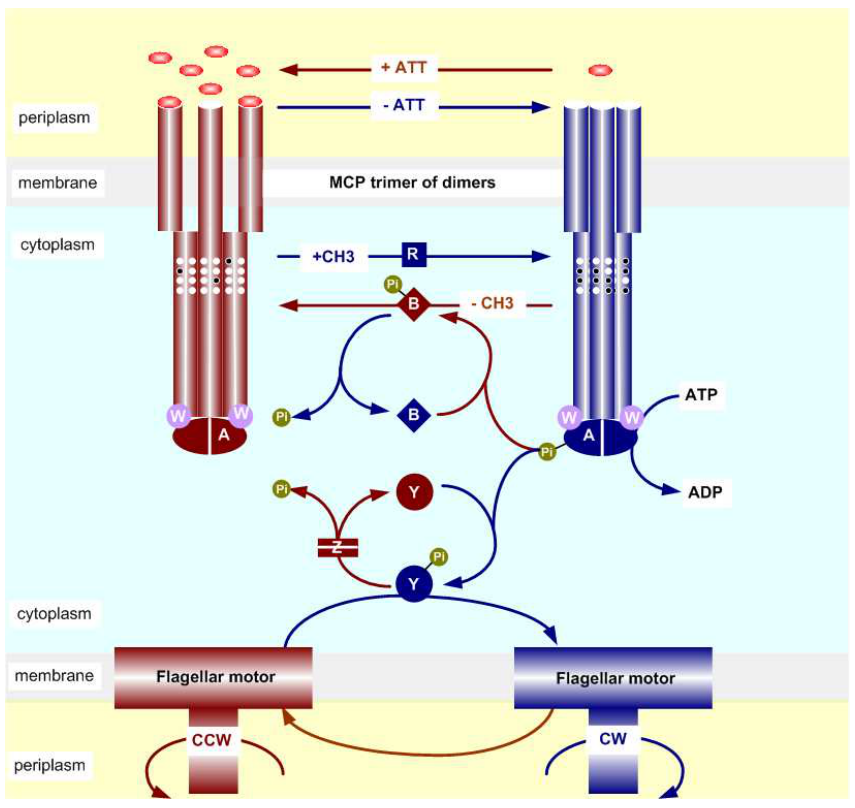
Figure 2. A schematic of the signal transduction pathway in E. coli . The trimer of chemoreceptor homodimers spans the cytoplasmic membrane, with a ligand-binding domain on the periplasmic side and a signaling domain on the cytoplasmic side. The cytoplasmic signaling proteins, denoted Che in the text, are identified by single letters, e.g., A = CheA. Proteins and reactions in red promote counterclockwise (CCW) rotation of flagella, and those in blue promote clockwise (CW) rotation of flagella. Receptor methylation sites involved in adaptation are shown as white (demethylated) and black (methylated)